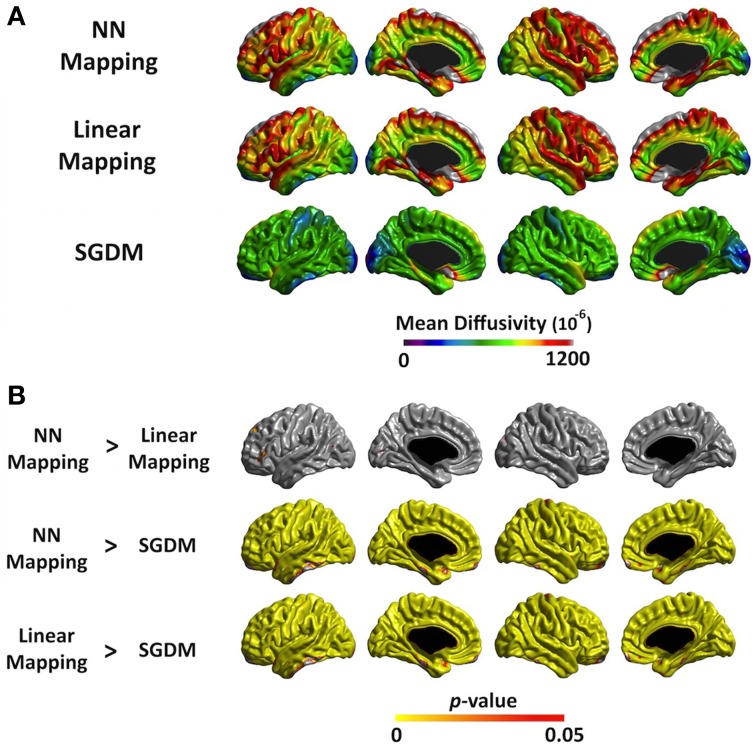
(A) The average MD value map for NN, Linear, and SGDM method in affine registration. The color scale on the bottom represents the MD values with a range of 0–1200−6. (B) Statistical maps of the differences in MD values among the three methods in affine registration. The color scale on the bottom represents the multiple comparison corrected p < 0.05.